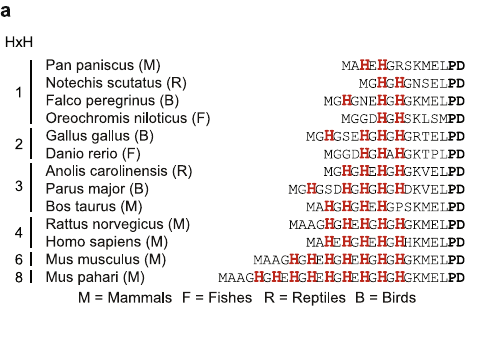
Fig. 5 METTL9-mediated methylation affects mitochondrial respiration and reduces the binding af fi nity of a zinc transporter peptide to Zn 2 + . a Sequence alignment of the N-terminal end of NDUFB3 orthologues from various vertebrate species. Histidines are shown in red and the number of HxH indicated. Residues “ PD ” (in black, bold) are conserved in all vertebrates. b Oxygen consumption rate (OCR) of digitonin (Dig)- permeabilized WT (blue), METTL9 KO (KO, red), METTL9 KO complemented with WT (KO + METTL9 WT, purple) or D151K/G153R mutant mMETTL9-HA (KO + METTL9 mut, orange) HEK293 cells. Respiration mediated by Complex I was assessed under basal conditions, and after sequential addition of ADP/pyruvate (Pyr)/malate (Mal), oligomycin (OMA), and antimycin A (AMA). Shown are OCR traces (top) and quanti fi cation of respiratory states (bottom). Mean ± s.d. ( n = 17 (KO), 11 (WT), 10 (KO + METTL9 WT), or 4 (KO + METTL9 mut) biologically independent samples). *** P < 0.001; ** P < 0.005 (state III: P = 0.00372, state IV: P = 0.00157); two-sided Dunnett ’ s multiple comparison test. c Dissociation constant ( K d ) between Zn 2 + and a synthetic SLC39A7 peptide that contains either none (Me0) or six 1MH (Me6) residues in an HxH context (methylated histidines underlined). Mean ± s.d. ( n = 3 independent experiments). *** P = 0.000451; two-tailed Student ’ s t test. Source data are provided as a Source Data fi